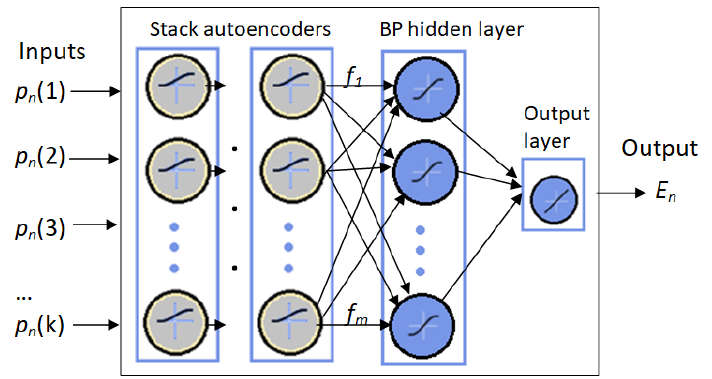
Figure 7. Energy consumption estimation model using a DLNA network.